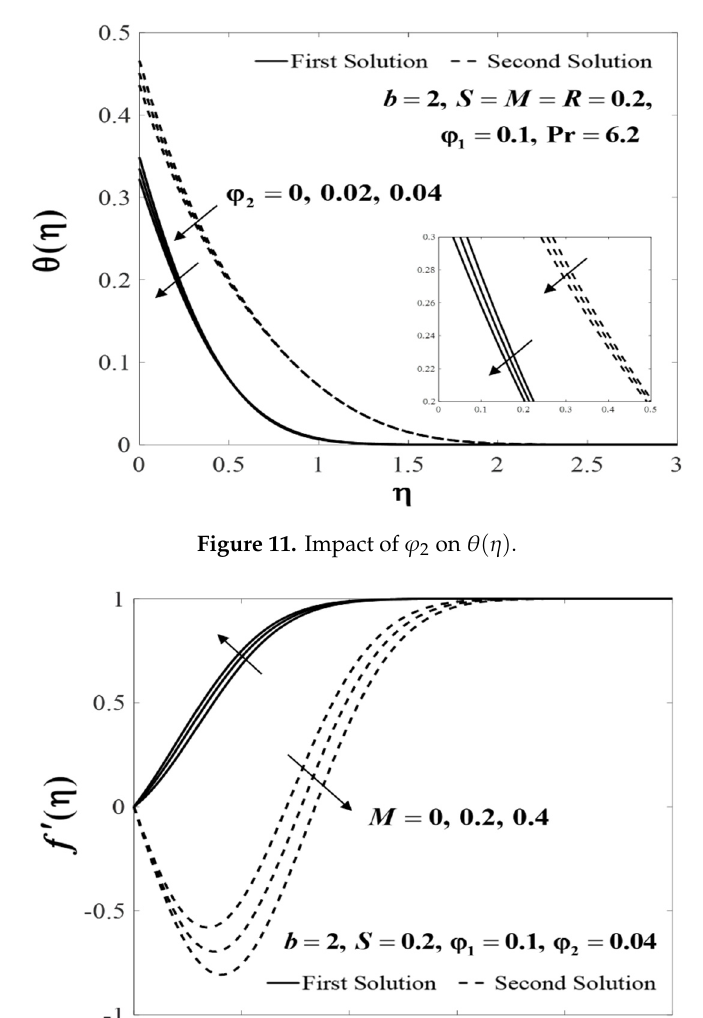
Figure 10. Impact of 𝜑 (cid:2870) on 𝑓 ′ (𝜂) .